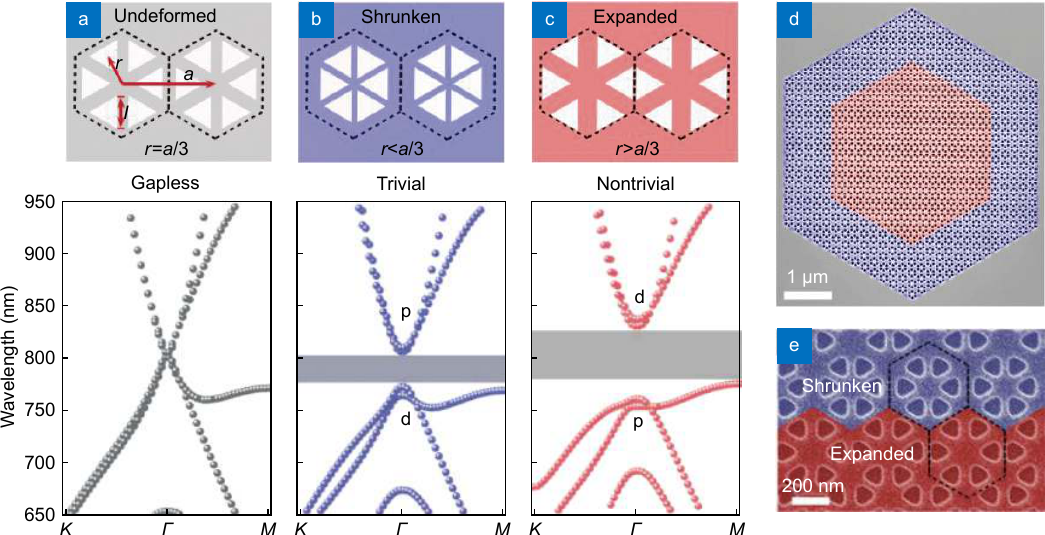
Fig. 1 | The design and band structure of the proposed Z 2 PTI. ( a – c ) Schematic of undeformed, shrunken, and expanded PhCs with their cal- culated band structures. The dashed hexagon outlines the structure unit cell, and the white triangle represents the hole area. The lattice constant a = 444 nm, the length of triangular hole l = 154 nm. The distance r between the unit cell center and triangular hole centroid for shrunken PhC is 138 nm, and for expanded PhC is 160 nm. The graphene-like band structure is formed when r = a /3 (undeformed), and topological trivial and non-trivial bandgaps can be opened at Γ point, when r < a /3 (shrunken) and r > a /3 (expanded), respectively. ( d ) Pseudo-colored SEM image of a fabricated structure. The outside shrunken and inside expanded PhCs are identified by blue and red regions, respectively. ( e ) Zoom-in SEM im- age of the interface area. Black dashed lines identify the unit cell of shrunken and expanded